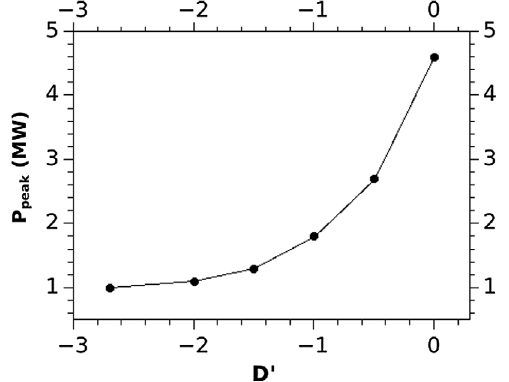
FIG. 8. Predicted stripping efficiency versus laser beam in- cident angle for laser peak powers of 1 and 2 MW.